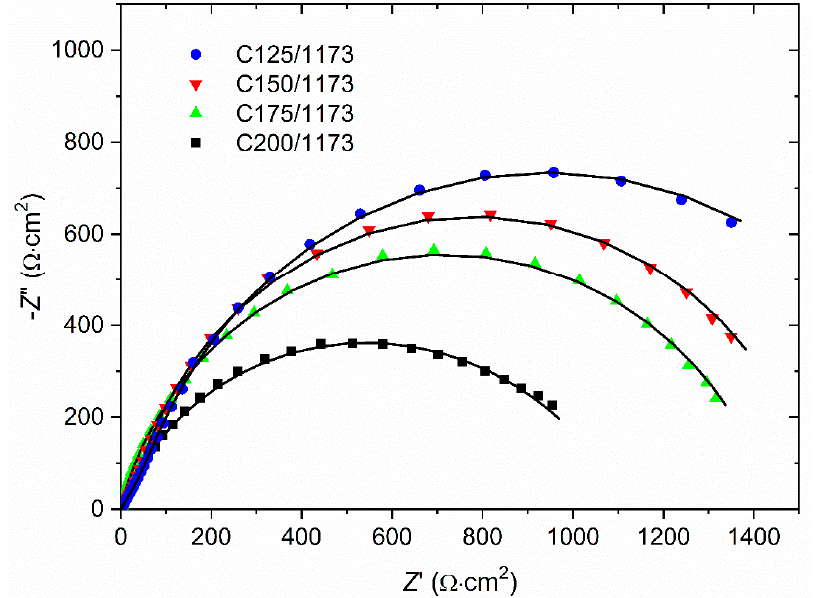
Figure 4. Nyquist plots registered in 5 wt.% NaCl solution for the Ni-W coatings after heat treatment in the air, in dependence on deposition current density; symbols–experimental points, solid lines–approximations using the one-CPE